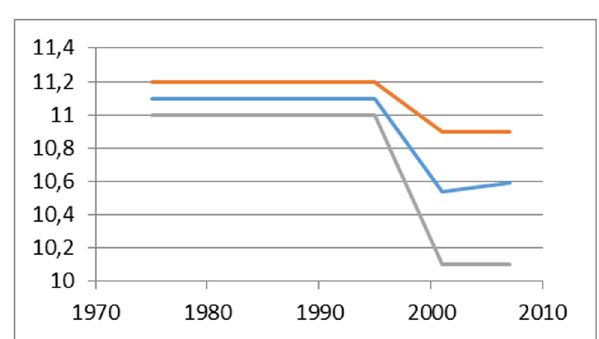
Figure 11: Histogram of random variation in thickness of corroded sheets obtained for the fi rst coating sheet of the tank number 2. The measurements were taken in 2007. Mean value ( estimated from the sample ) 10.69 mm, standard deviation 0.19 mm, coe ffi cient of var - iation 0.018.